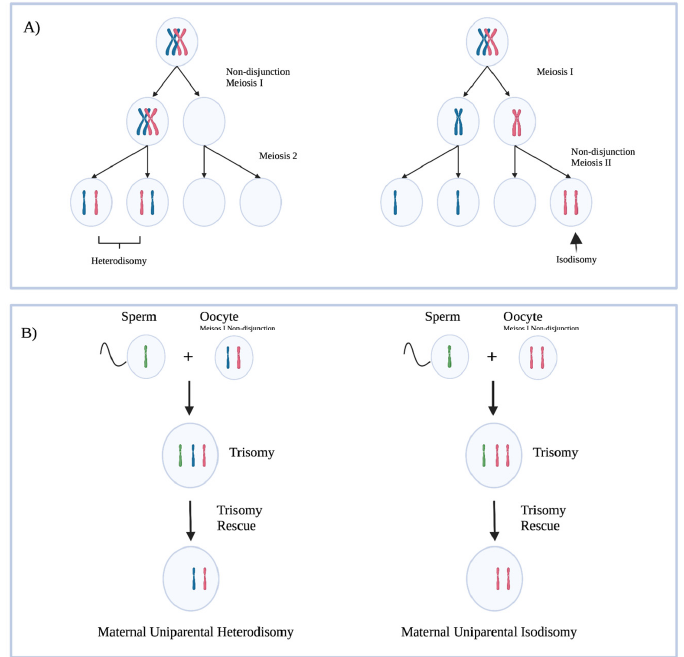
Figure 2. ( A ) A representation of non-disjunction events in meiosis leading to abnormal chromosome copy numbers in gametes. Hetrodisomy refers to a gamete with each copy of a chromosome present. Isodisomy refers to a gamete with two copies of the same chromosome present. ( B ) Trisomy rescue leading to maternal uniparental disomy. Trisomy rescue in these cases does not always result in a maternal uniparental disomy in the cases outlined above; a maternal chromosome could have been lost. The outcomes of interest are displayed in the figure. Created with BioRender.com. (accessed on 25 March